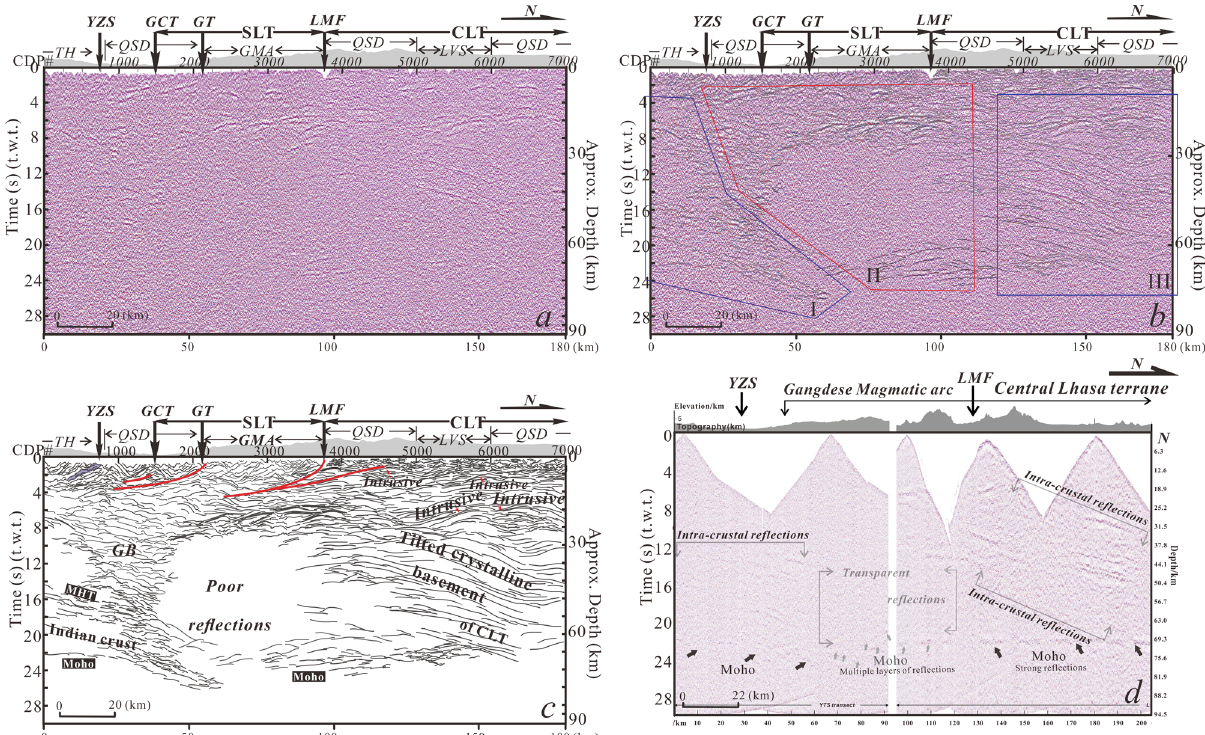
Fig. 2 Deep seismic re fl ectivity data. a Uninterpreted 180-km-deep migrated seismic re fl ection pro fi le (no vertical exaggeration) along 88.5 ˚ E. See Fig. 1 for location. b Superposition of composite line drawings of high-amplitude re fl ections. c Delineation of tectonic units in the fi ne-scale crustal transverse structure. d Single-shot section from the 2000 kg explosive source along the pro fi le. Differentiation in intra-crustal re fl ections is observed from the south to the north, outlining three different domains within the tectonic converging zone. TH Tethyan Himalaya, QSD Quaternary sedimentary deposit, MHT Main Himalayan Thrust. See more abbreviations in Fig.